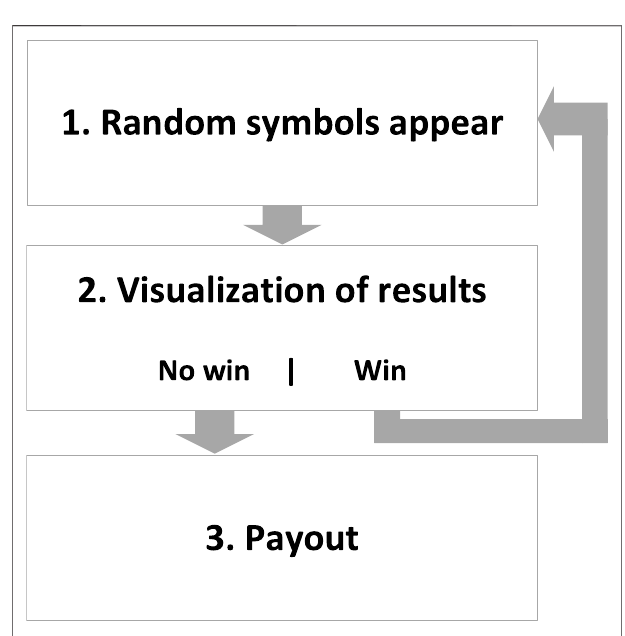
FIGURE5| Random symbolsaredrawnatthestartofaround(1).Then, the game checks all win lines for wins. In the case of a win, they are visualized (2) and new symbols are drawn. If no (further) wins are detected, the fi nal payout is displayed and added to the account (3).